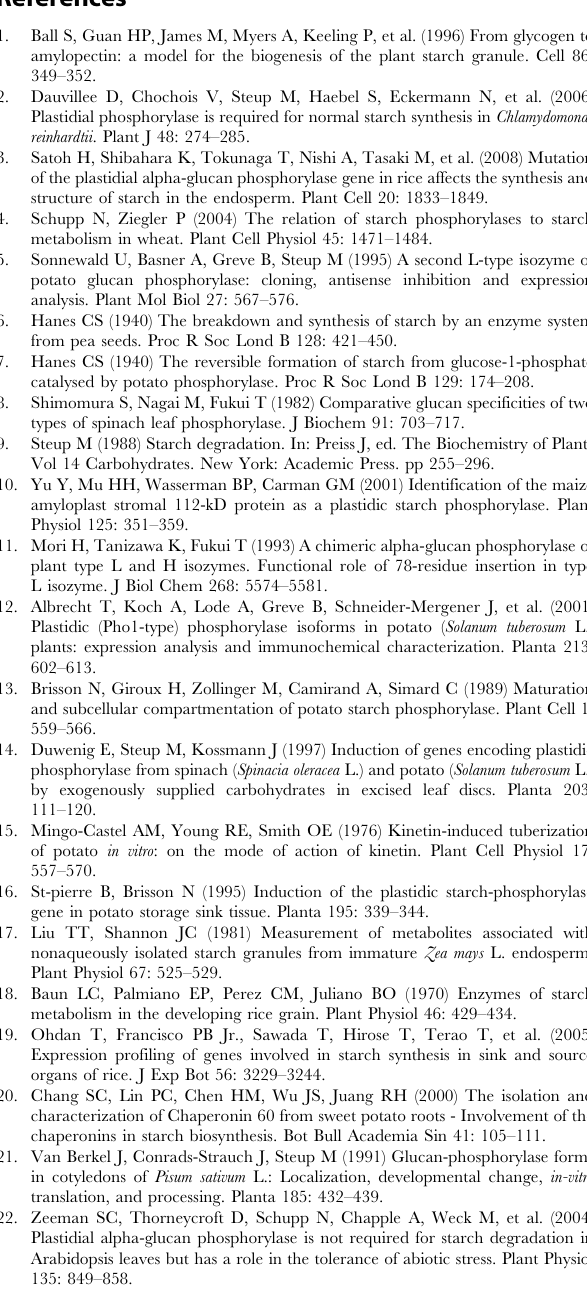
marked with asterisks (*). The conserved substitutions among different sequences were denoted as colons (:). Figure S4 Pho1 in potato tubers undergoes proteolytic degradation upon heat treatment. Potato tubers discs (2 mm thickness) were incubated at 45 u C for the indicated time periods up to 48 h. ( A ) The crude protein extracts of the discs (10 m g) were separated by 7.5% native PAGE and analyzed by Coomassie staining, Pho1 activity staining or western blot analysis with a Pho1 polyclonal antibody, respectively. ( B ) Alternatively, the same samples above were subjected to 12.5% SDS-PAGE and analyzed by Coomassie or western blot analysis with a Pho1,